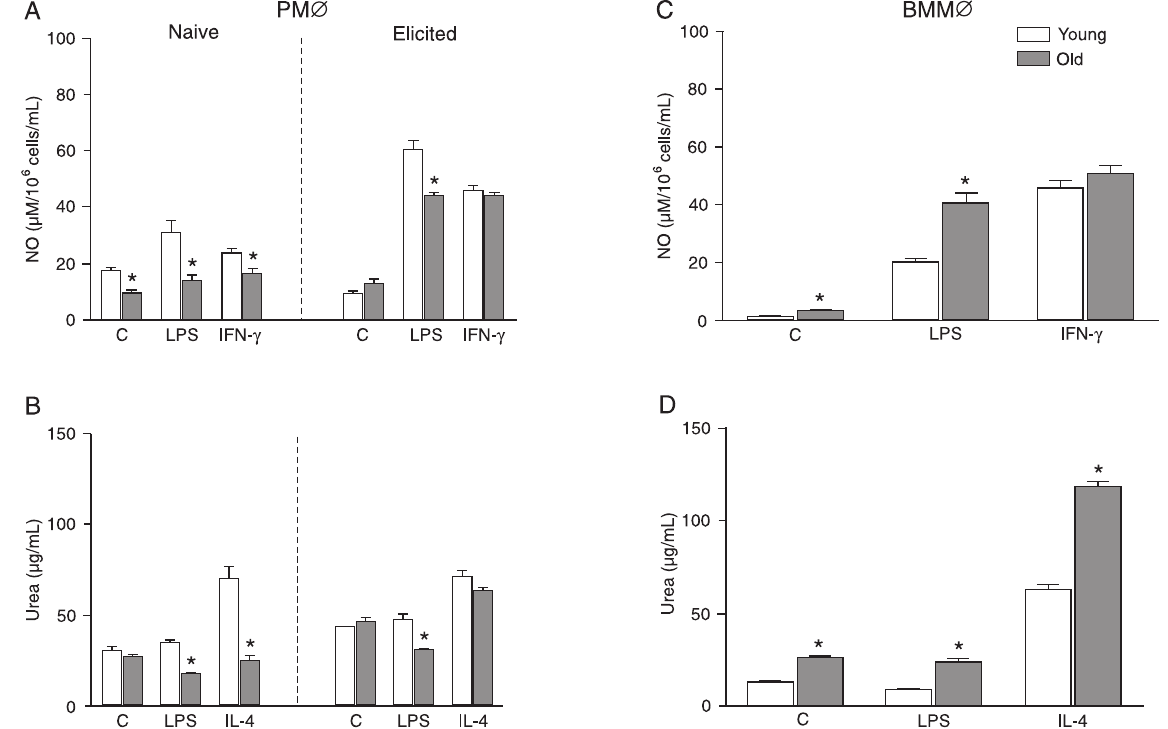
Figure 4. Aging affects inducible nitric oxide synthase (iNOS) and arginase activities in macrophages of BALB/c mice. Naive mice (N = 14) were the source of naive peritoneal macrophages and bone marrow-derived macrophages. Elicited macrophages were ob- tained from mice (N = 6) injected 4 days previously with thioglycolate medium. Young and old mice were used at the ages of 8 and 72 weeks, respectively. Adherent cells were cultured in the presence of lipopolysaccharide (LPS; 1 μg/mL), interleukin-4 (IL-4; 40 IU/mL) or interferon-γ (IFN-γ; 50 IU/mL) for 48 h at 37°C, in 5% CO 2 . Cells of the control groups (C) were incubated in the absence of stimuli. Nitrite was measured in the culture supernatants using a Griess reagent, and arginase activity was determined in cell lysates based on the amounts of urea converted from L-arginine. All studies were conducted in triplicate. Bars indicate the means ± SEM of nitrite (Panels A, C) or urea (Panels B, D) levels in three independent experiments. *P ≤ 0.05 compared to control (Student t